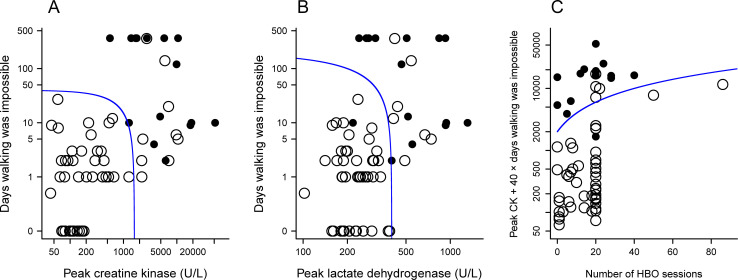
Relationship between explanatory variables and the development of delayed neurological sequelae (DNS).Closed circles indicate DNS patients and open circles indicate non-DNS patients. A. The explanatory variables are peak creatine kinase (peak CK, x-axis) and the time for which walking was impossible (WALK, y-axis). The blue line indicates the equation, peak CK (U/L) + 40 × WALK (days) = 1600. B. The explanatory variables are peak lactate dehydrogenase (peak LDH, x-axis) and the time for which walking was impossible (WALK, y-axis). The blue line indicates the equation, peak LDH (U/L) + 2 × WALK (days) = 400. C. The explanatory variables are peak CK, WALK and the number of hyperbaric oxygen (HBO) sessions. On the y-axis is the score, peak CK (U/L) + 40 × WALK (days). The blue line indicates the equation, peak CK (U/L) + 40 × WALK (days) - 200 × the number of HBO sessions = 2000.